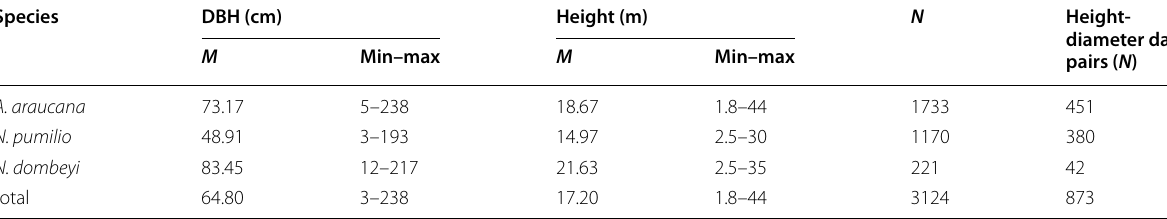
Table 1 Summary of the complete database Species DBH (cm) DBH diameter at breast height, M mean value, N number